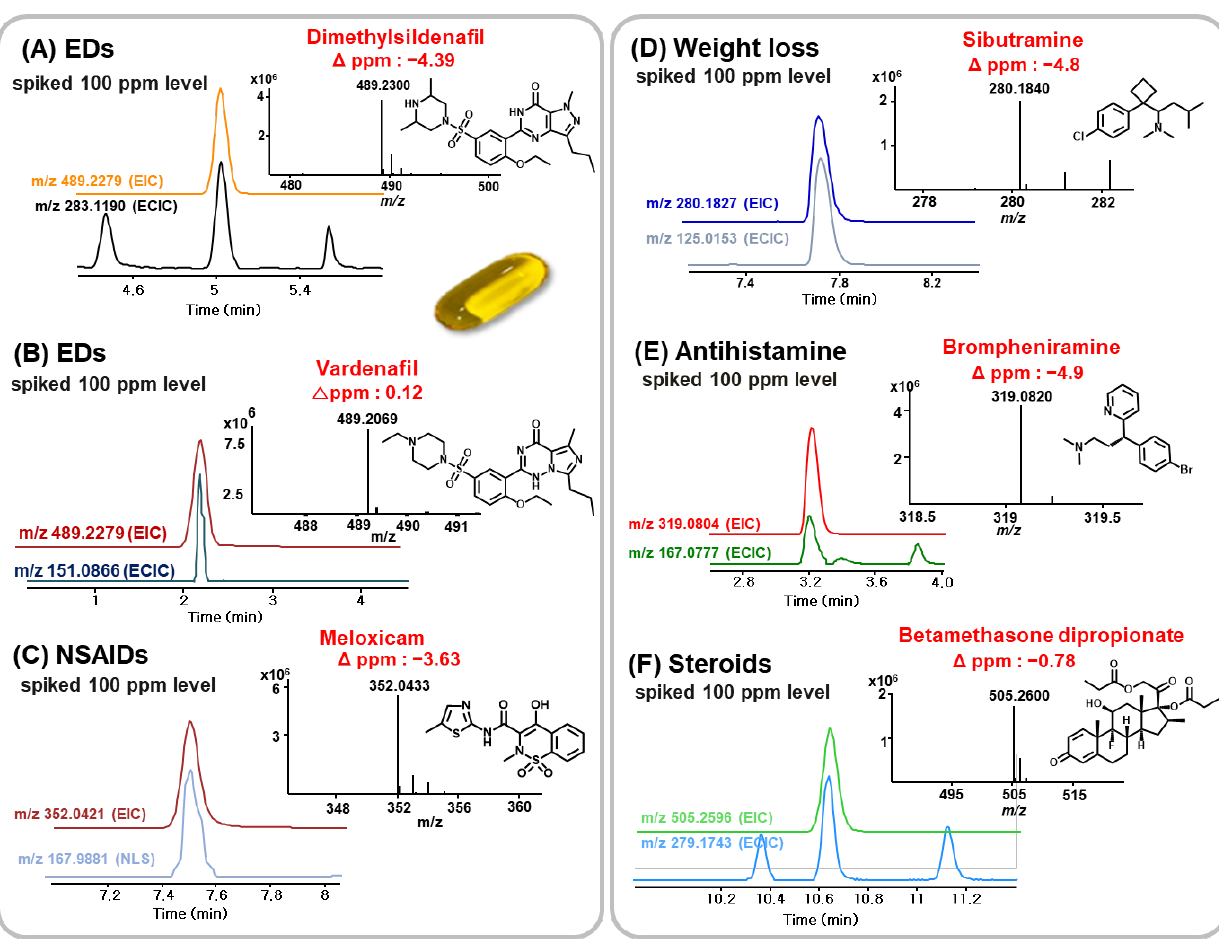
Figure 6. EIC, ECIC and NLS screening and confirmation of illegal adulterants in soft-gel samples.